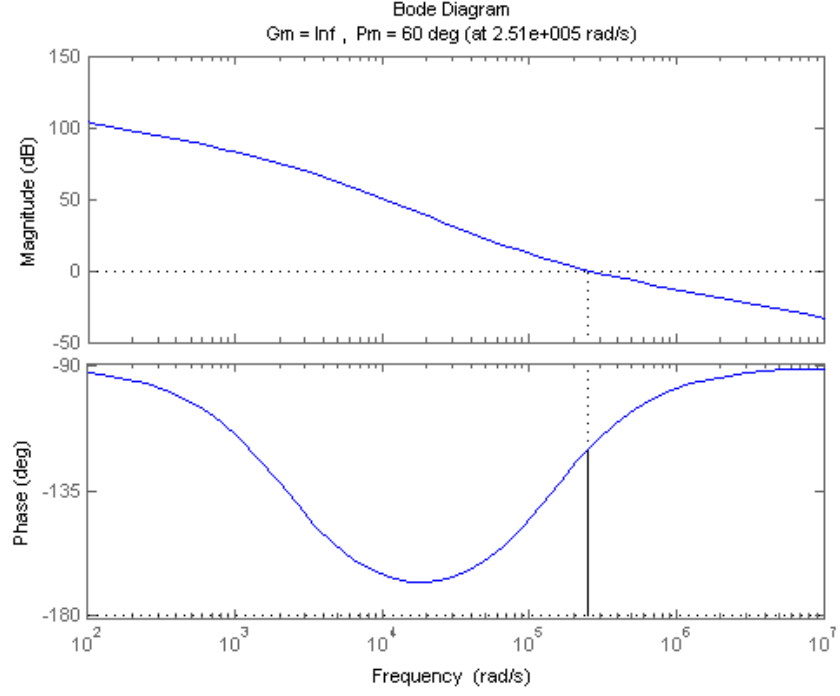
Figure 7. Bode plot of current control loop with the PI controller: PM = 60° at f c = 251 krad/s.